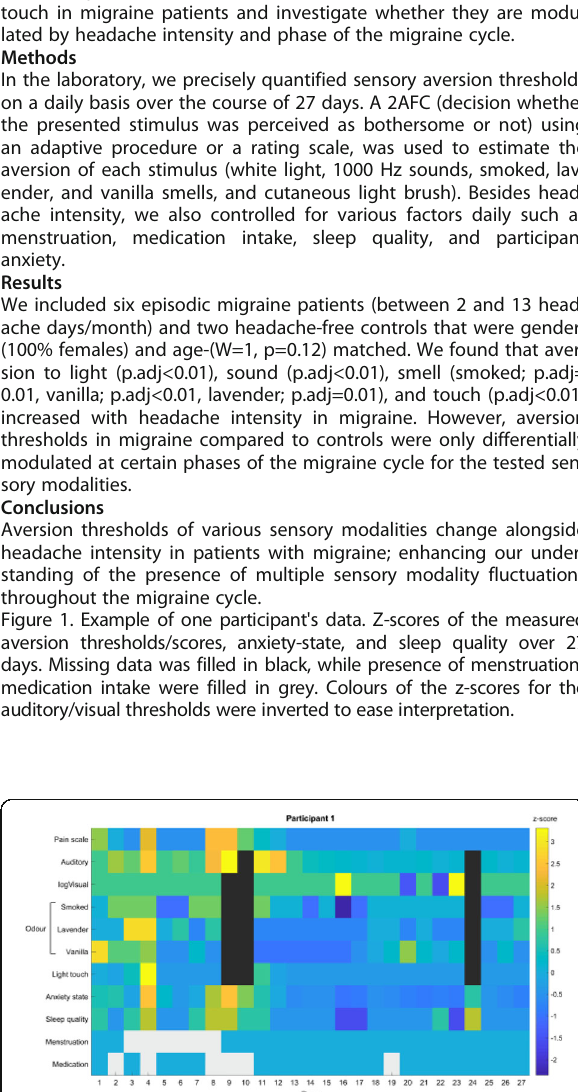
Fig. 1 (abstract P133). See text for